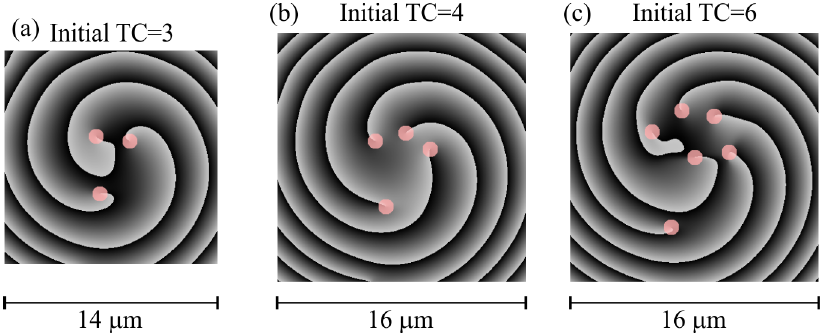
Figure 8. Phase patterns represent optical vortices at a distance of z = 20 μ m for different initial TC: 3 ( a ), 4 ( b ) and 6 ( c ). Positive dislocations are purple shaded circles. Field sizes are 14 × 14 μ m for TC = 3, 16 × 16 μ m for TC = 4 and 6.